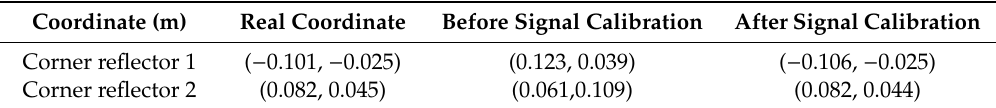
Figure 7. InISAR imaging results of two corner reflectors. ( a ) Before signal calibration; ( b ) After signal calibration.